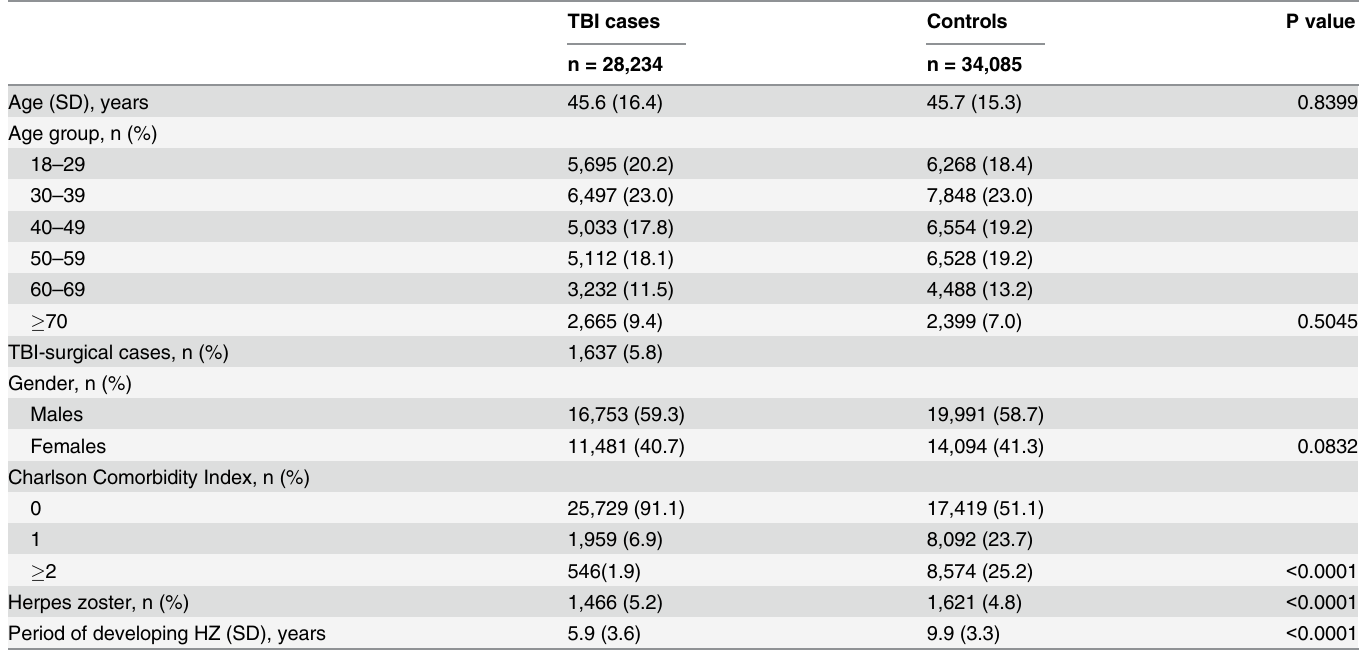
Table 1. Characteristics of adult patients with traumatic brain injury and control cohorts in Taiwan, 1996 –